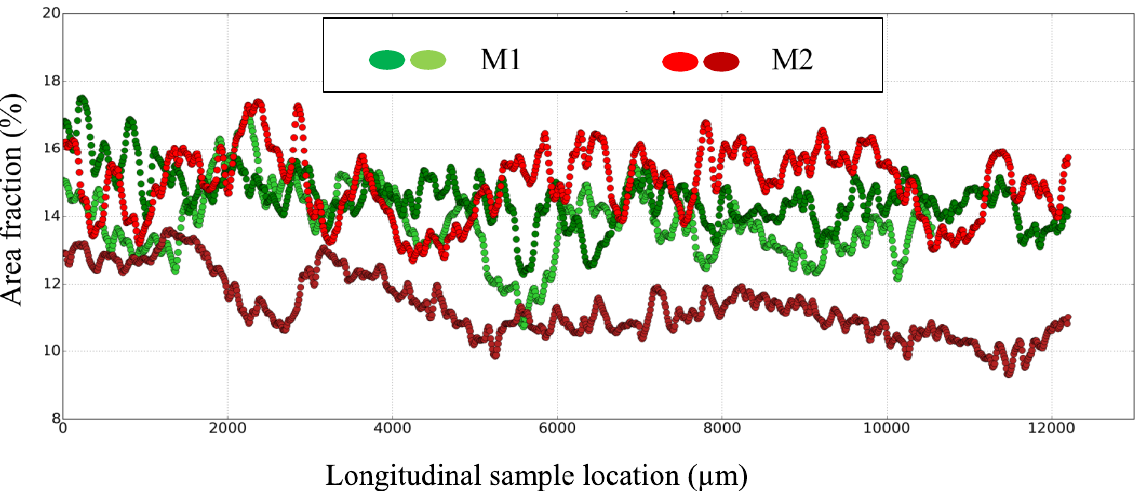
Figure 9. Spatial carbonaceous particles in two 16 mm-diameter specimens sampled from M1 and M2.